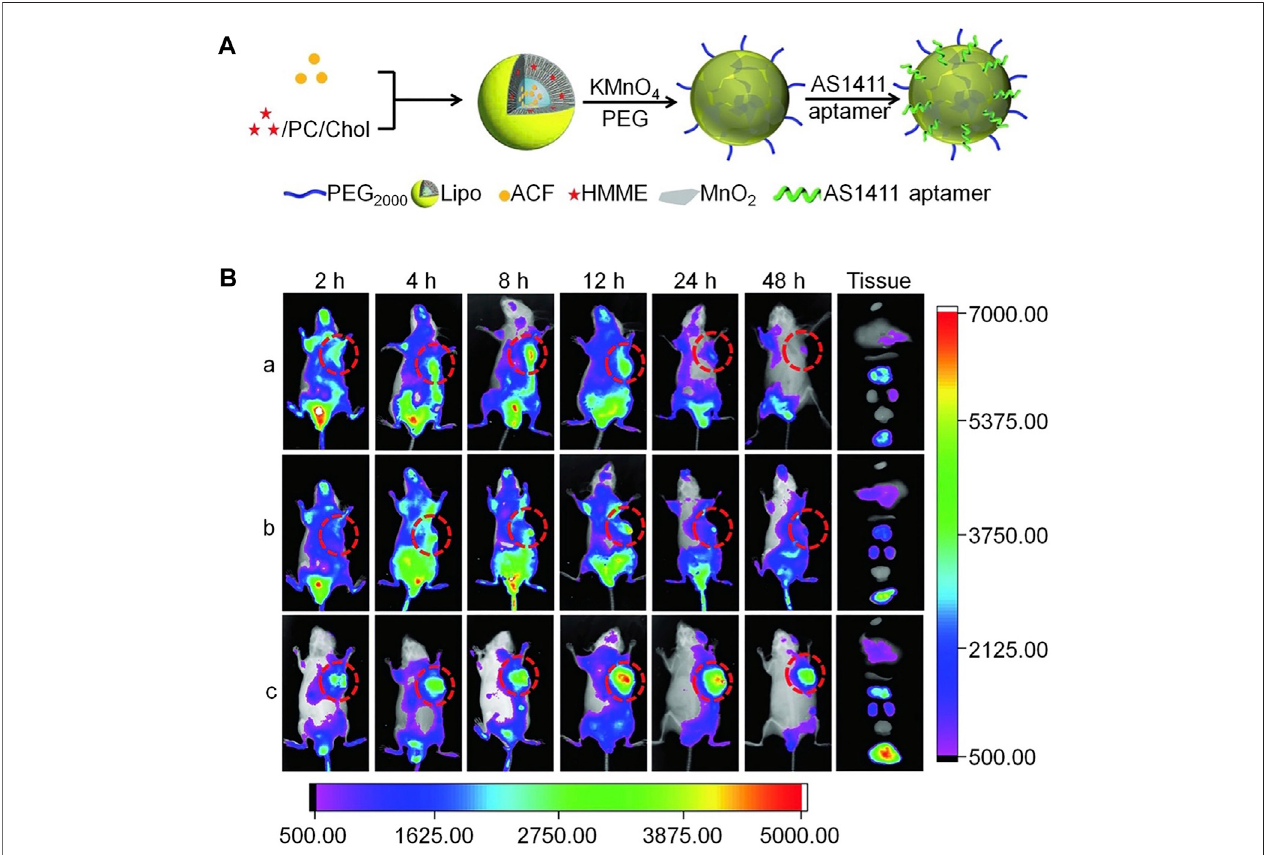
FIGURE 9 | Aptamer-modi fi ed multifunctional nanodrug delivery platform for ovarian cancer treatment. (A) Schematic illustration of the Lipo/HMME/ACF@MnO 2 - AS1411 synthesis process. (B) In vivo near-infrared (NIR) fl uorescence images of different formulations in SKOV-3 tumor-bearing nude mice injected intravenously. (A) IR780, (B) Lipo/IR780@MnO 2 , and (c) Lipo/IR780@MnO 2